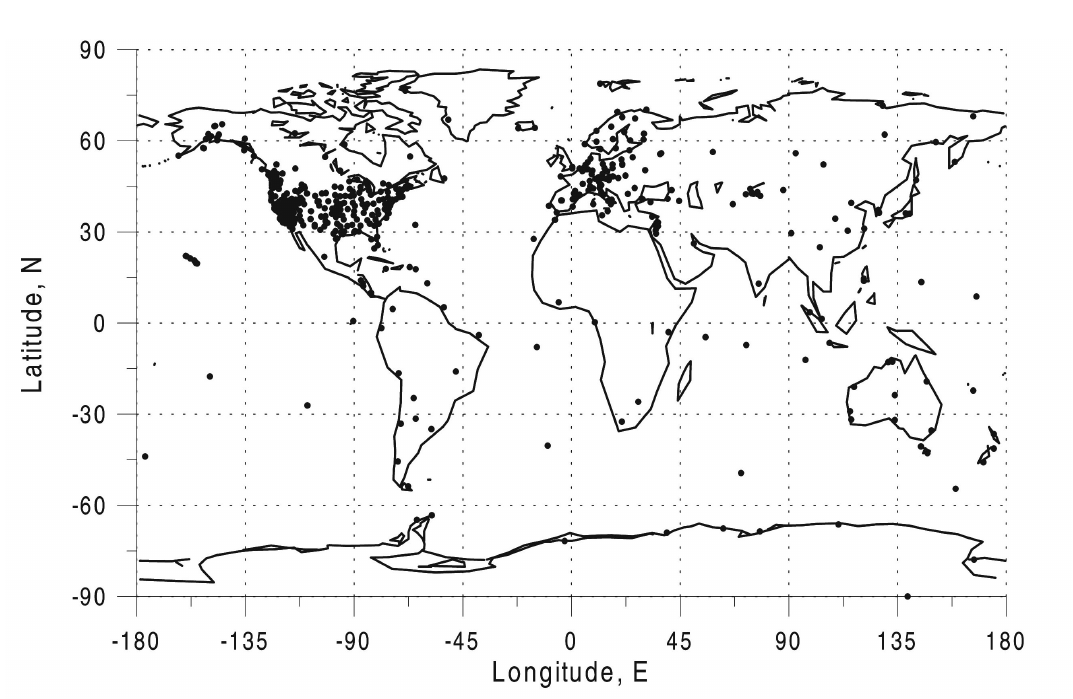
Fig. 1. The map shows the location of the receiving stations of the global GPS network that posts data on the Internet. The number of receiving sites totals more than 1000 as of the beginning of